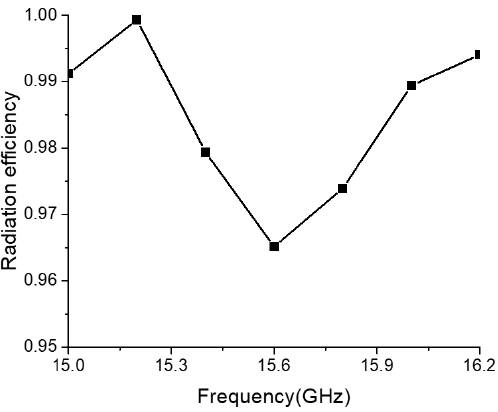
Figure 10. Simulated radiation efficiency of the array at broadside.